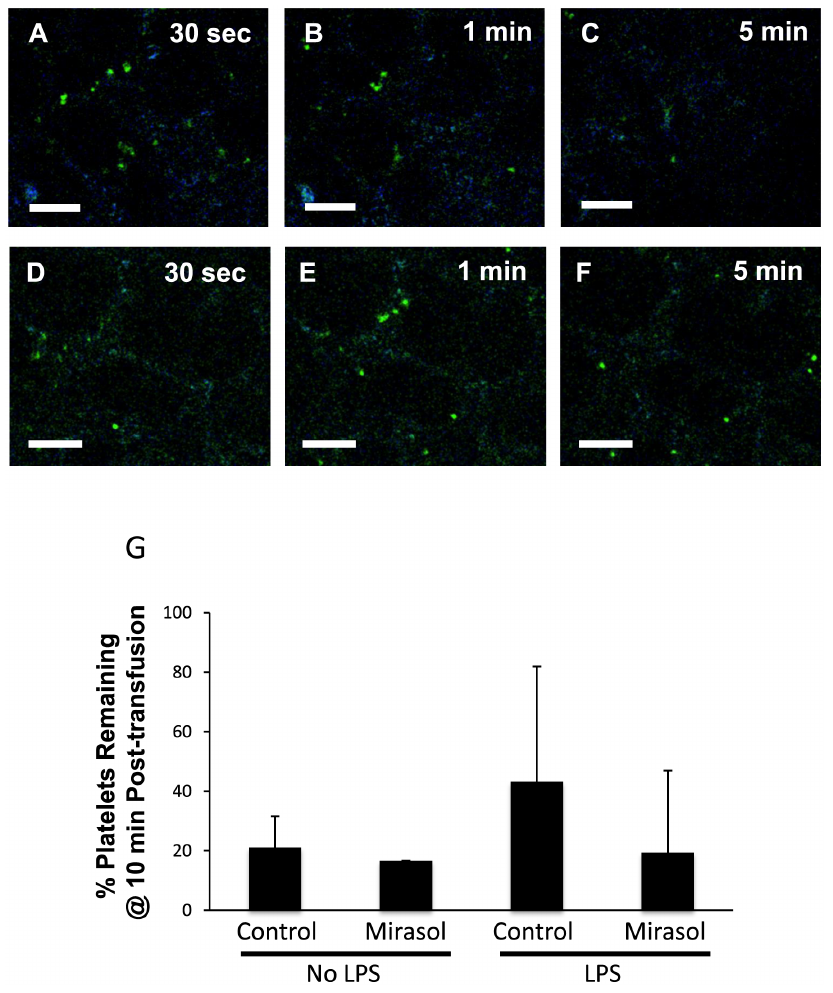
Fig 5. Real-time lung imaging of human platelets in the lungs of NOD/SCID mice. Lung intravital microscopy in unprimed NOD/SCID mice transfused with CFSE-labeled control (A-C) or Mirasol-PRT platelets (D-F) both on storage day 5 (10 9 platelets). Images were captured every second for 10 minutes and screenshots are shown from 30 sec, 1 min, and 5 min post-transfusion. Scale bar = 50 μ m. (G) %Platelets remaining in the imaged lung @ 10 minutes post-transfusion (# at 10 min/maximum #) in NOD/SCID mice ± LPS priming + Control vs. Mirasol PRT-treated